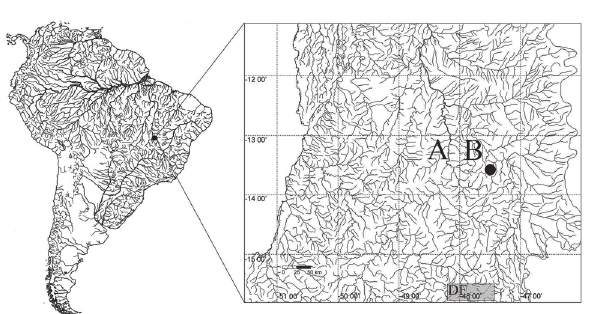
(SA) prepared by Marylin